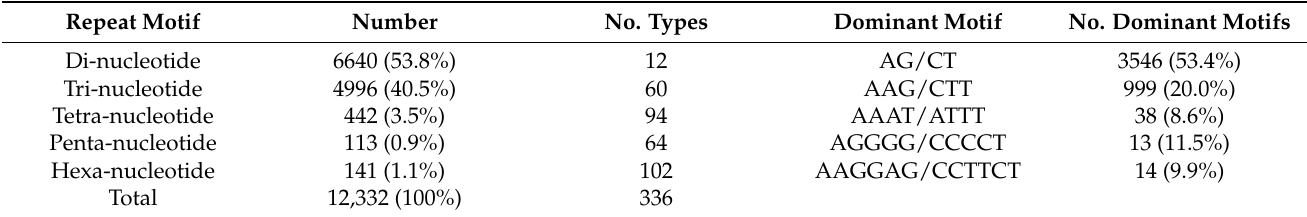
Table 4. SSR occurrence and composition in Chosenia arbutifolia .